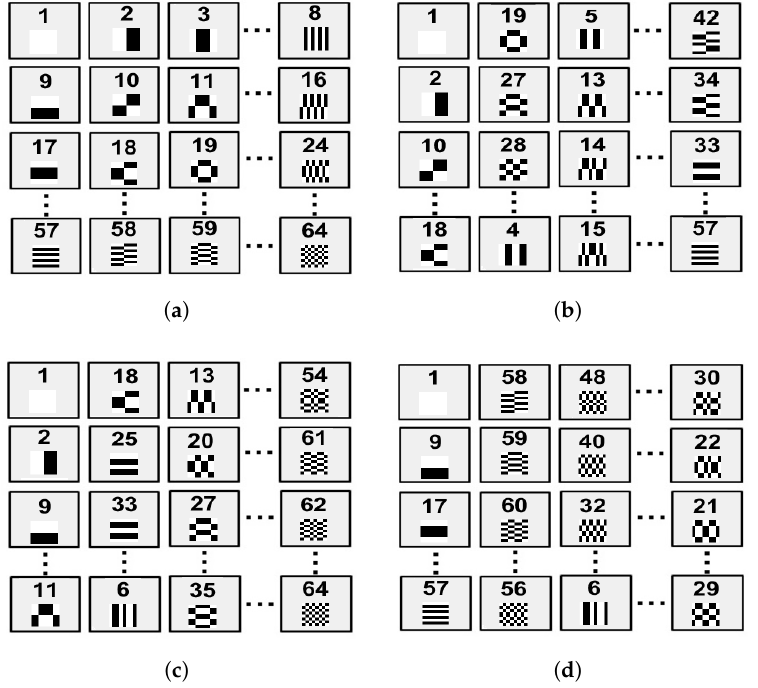
Figure 2. Example Hadamard sequence H 64 scanning scheme applying different space-filling curves: ( a ) basic Hadamard sequence, ( b ) Hilbert scan [22], ( c ) Zig – Zag scan [23], ( d ) Spiral scan